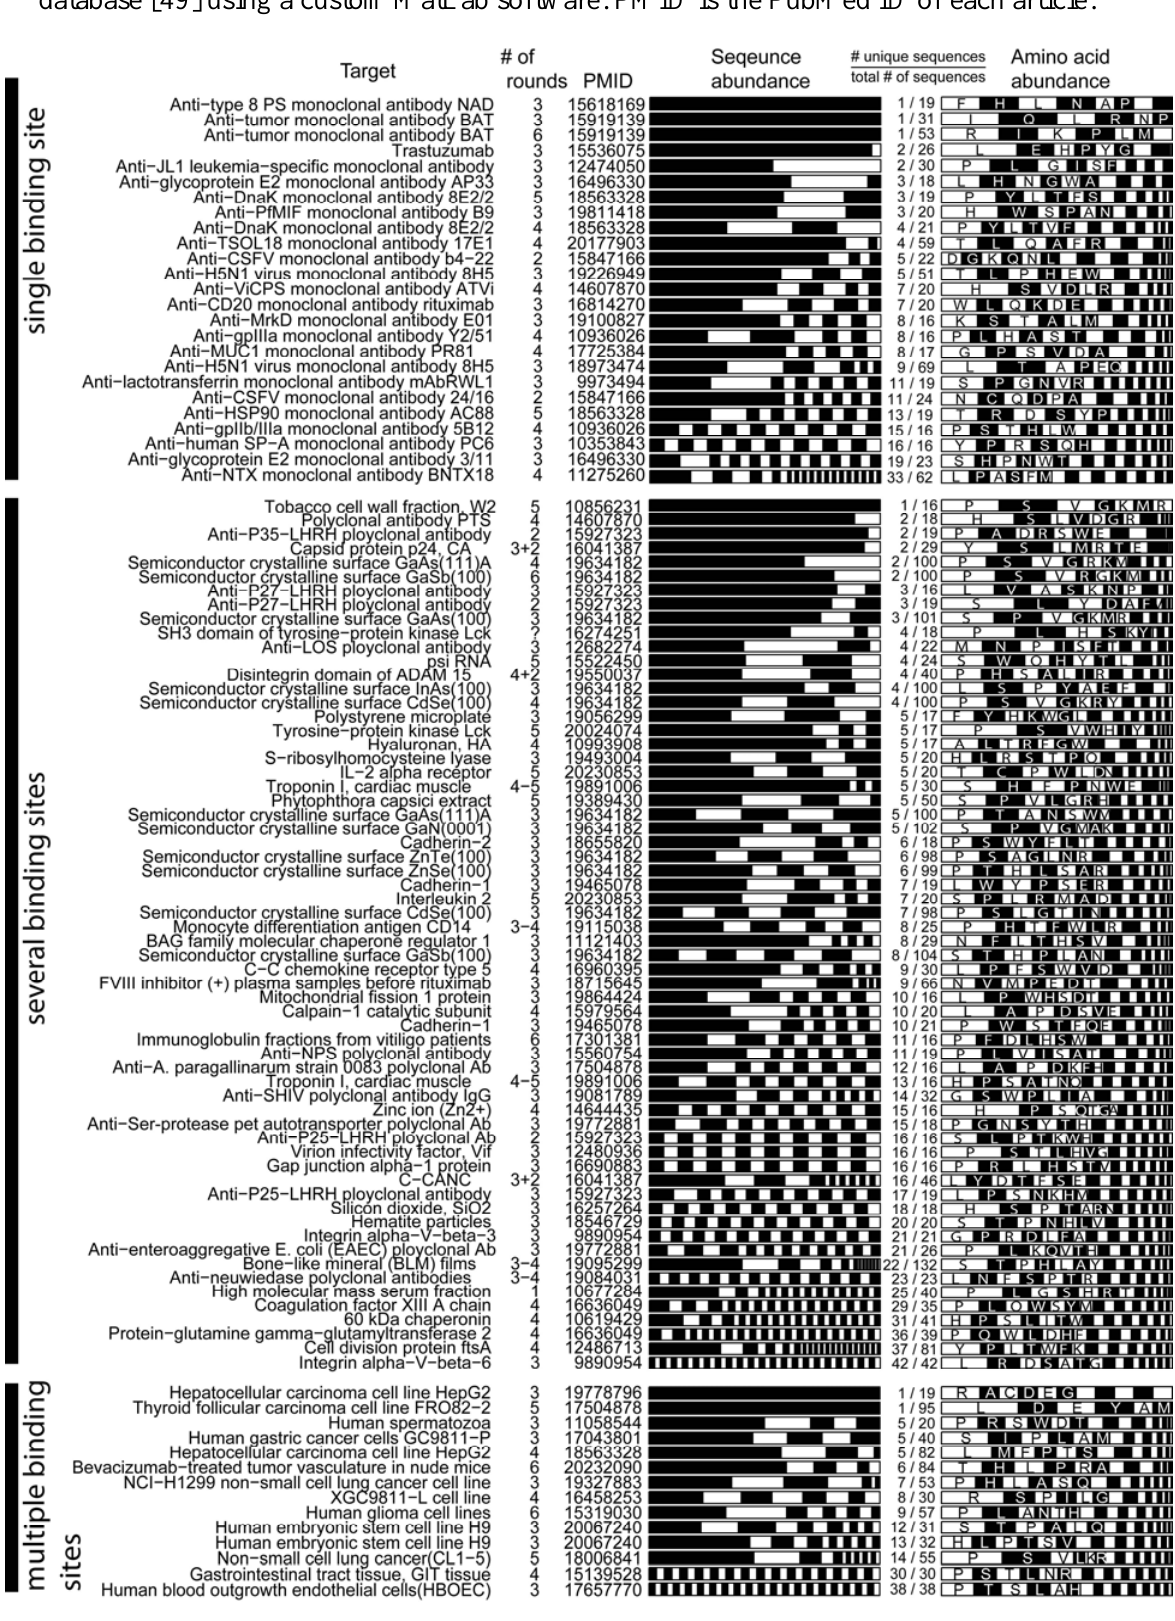
Figure 3. Analysis of the diversity of the Ph.D.-12 phage library after screening against various targets (see Figure 2 for an explanation of the stacked bar representation) from papers that report >15 DNA sequences. The data was extracted from raw MimoBD database [49] using a custom MatLab software. PMID is the PubMed ID of each